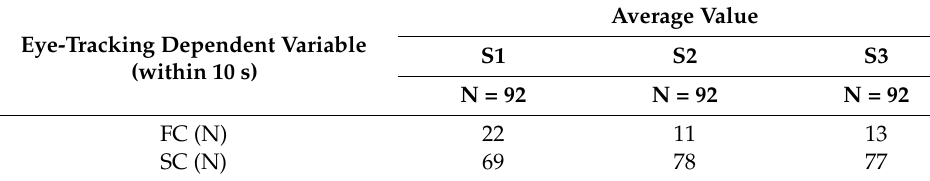
Table 8. Comparison of Eye-Tracking Index Data by